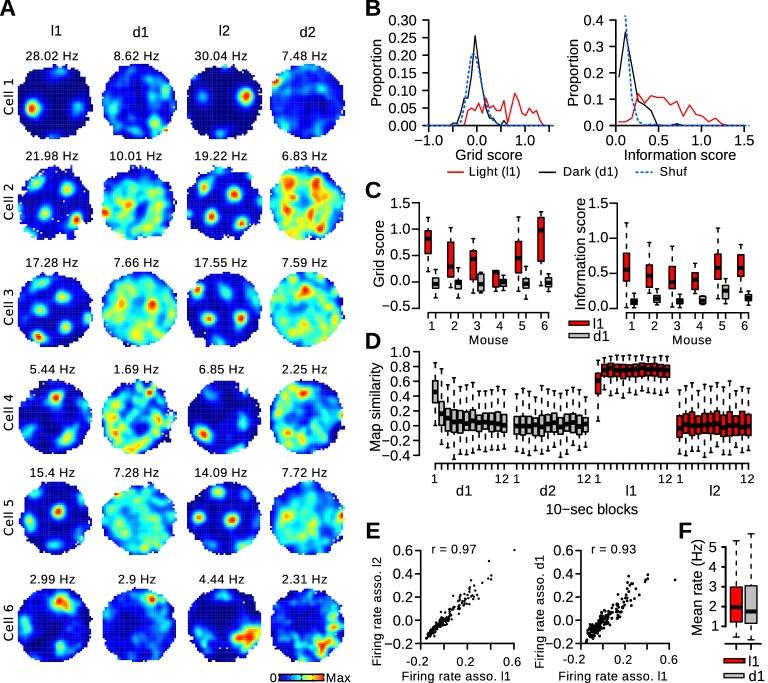
Rapid degradation of grid cell periodicity in absence of visual landmarks.(A) Firing maps of 6 grid cells during light and dark trials. (B) Distribution of grid and information scores of grid cells during l1 and d1 trials. The dotted blue line represents the surrogate (Shuf) distribution. (C) Grid and information scores during l1 and d1 trials for individual mice with at least 5 recorded grid cells. (D) Map similarity between 10-s block maps and l1 maps (left column in panel A). (E) Left: Firing rate associations of pairs of grid cells during l1 and l2 trials. Right: Firing rate associations of pairs of grid cells during l1 and d1 trials. (F) Mean firing rate of grid cells.